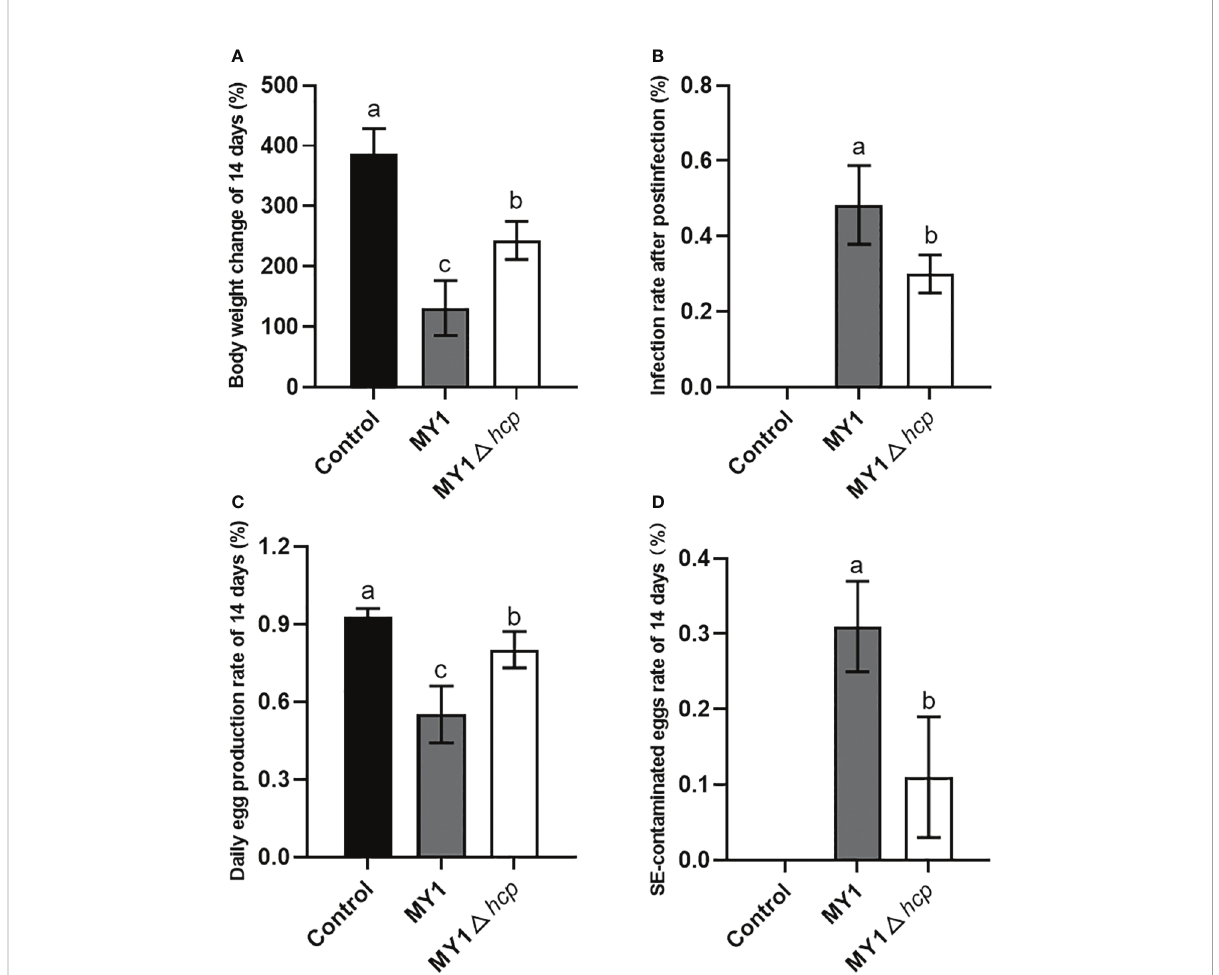
FIGURE 3 Measurement of body weight change, infection rate, daily egg production and egg contamination between MY1-infected and MY1 △ hcp - infected ducks. (A) The body weight change of the control, the MY1-infected and MY1 △ hcp -infected groups of 14 days. (B) The infection rate after postinfection between MY1-inoculated and MY1 △ hcp -inoculated ducks (n=3). (C) The daily egg production of the control, the MY1- infected and MY1 △ hcp -infected groups of 14 days. (D) The egg contamination rate of the control, the MY1-infected and MY1 △ hcp -infected groups of 14 days. Signi fi cant differences of daily egg production and egg contamination rate results were identi fi ed using one-way ANOVA statistical analysis (n=14). Different superscripts within columns indicate means are signi fi cantly different ( P <